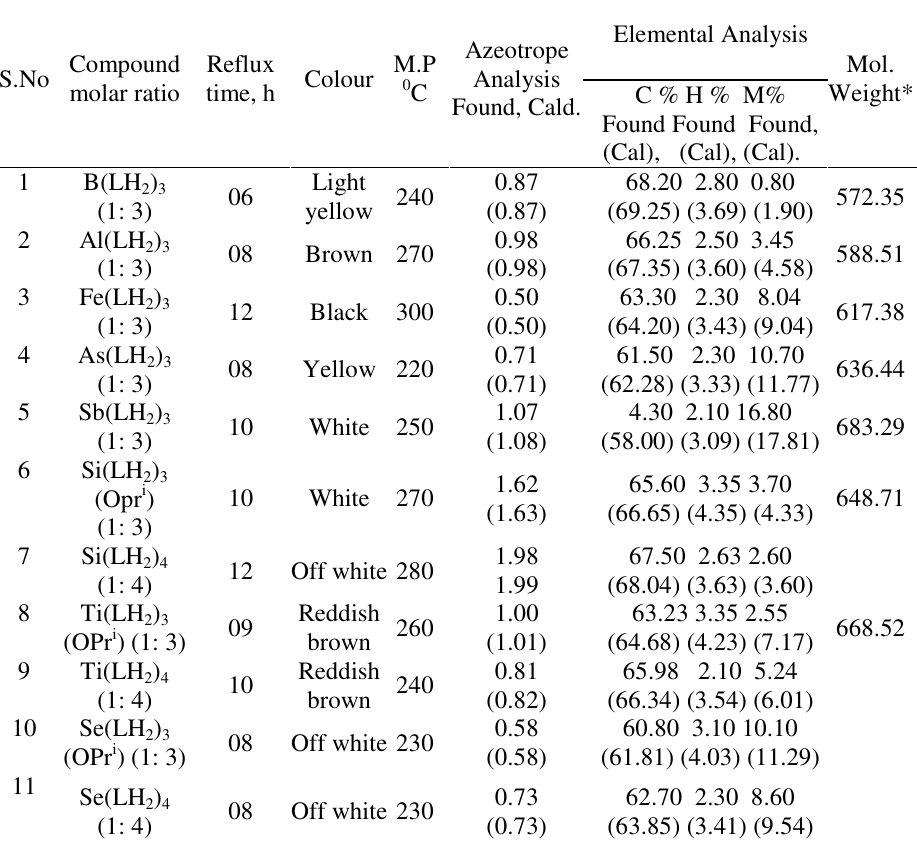
Table 1. Analytical details of the compounds of 2-hydroxy-1-naphthoic